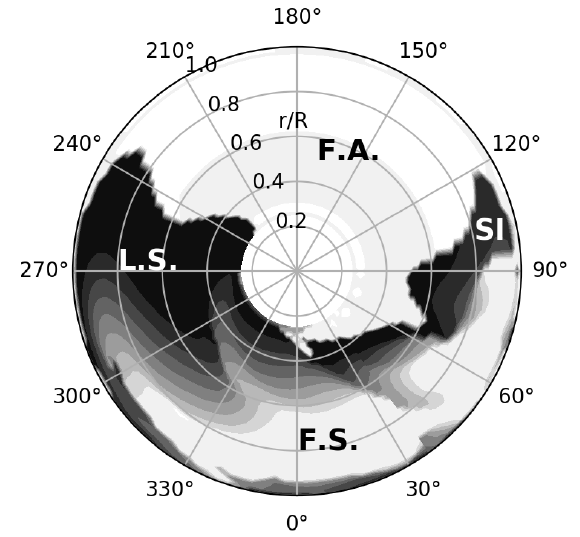
Figure 16. Rotor map of separation regions. F.A. is the fully attached region; L.S. is the leading edge separated region, where the LEV is attached, representing as the conical vortex structure on the rotating blade; F.S is the fully separated region due to the shedding of DSV; SI is the shock induced separation region.